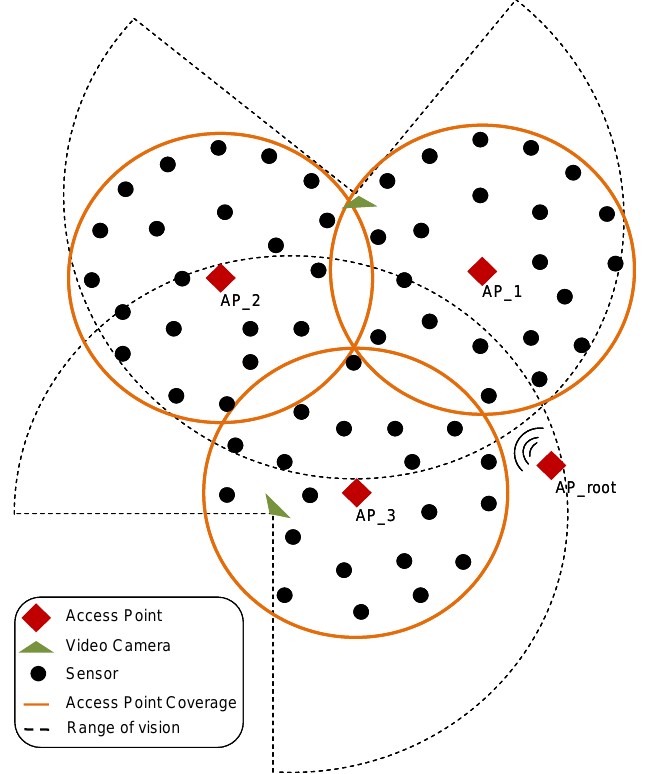
Figure 5. Number of devices needed per area that is wanted to be